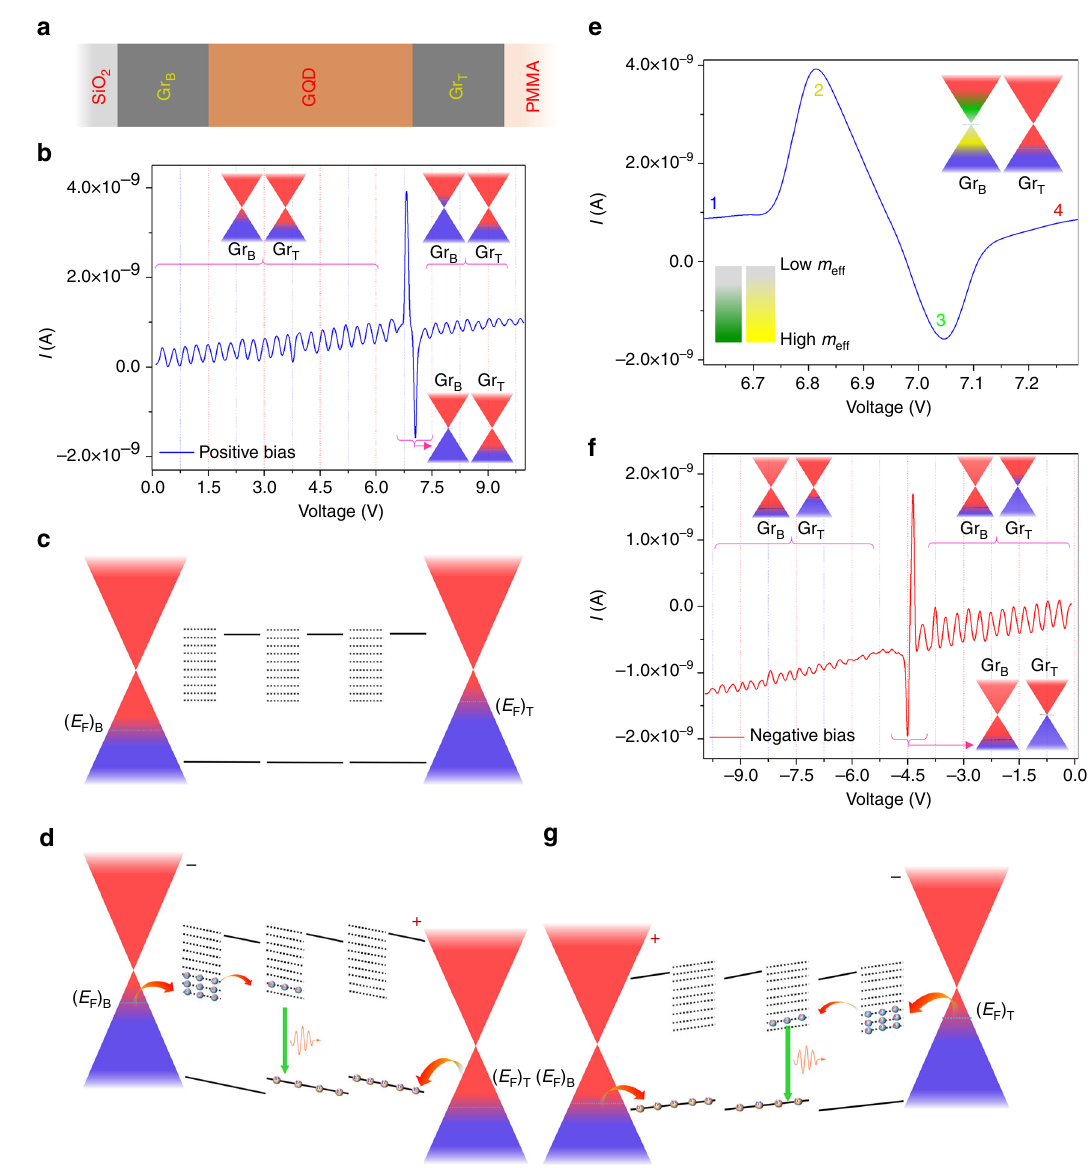
Fig. 1 All-graphene sandwich device exhibits quantum oscillations of current. a Schematic representation of the device. The top graphene (Gr T ) and bottom graphene (Gr B ) serve as the carrier injection layers to the GQDs. b Current oscillations due to resonant tunneling of electrons for positive bias. The inset shows the respective positions of Fermi energy ( black dot lines ) of both graphene at different regions. c The energy band diagram of different layers without application of external bias. The zero bias misalignment of Dirac point arises from the substrate effect. d The band structure with the application of positive bias shows a resonance tunneling of electrons. The recombination occurs due to the presence of holes in the valence band. e Magni fi ed I – V near the Dirac point. The yellow and green colors in the bottom graphene show the position of nearly zero effective mass ( m eff ) zone for the carriers. Inset color bars are cartoon diagrams representing the variation of m eff around the Dirac point. f Oscillation of current under negative bias. The I – V shows a π phase difference of current oscillations in opposite bias. The inset depicts the position of Fermi energy of the graphene at different bias voltage. g The energy band diagram of the composite under reverse